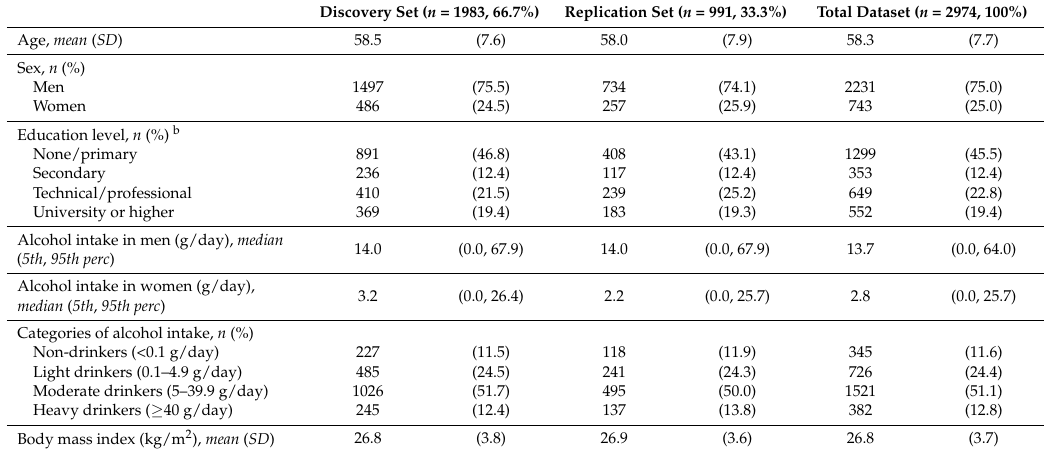
Table 1. Socio-demographic, lifestyle, and blood-sampling related characteristics of participants included in the total dataset and in the discovery and replication sets a